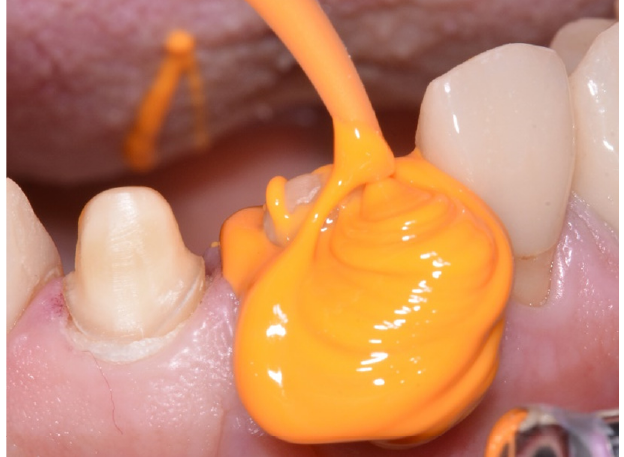
Figure 2. Application of a light-body elastomer to a prepared tooth in the upper jaw. Utilizing the double-mixing technique, the light body material is applied from a cartridge through a mixing can- ula with a tip directly placed on the hard and soft tissues.